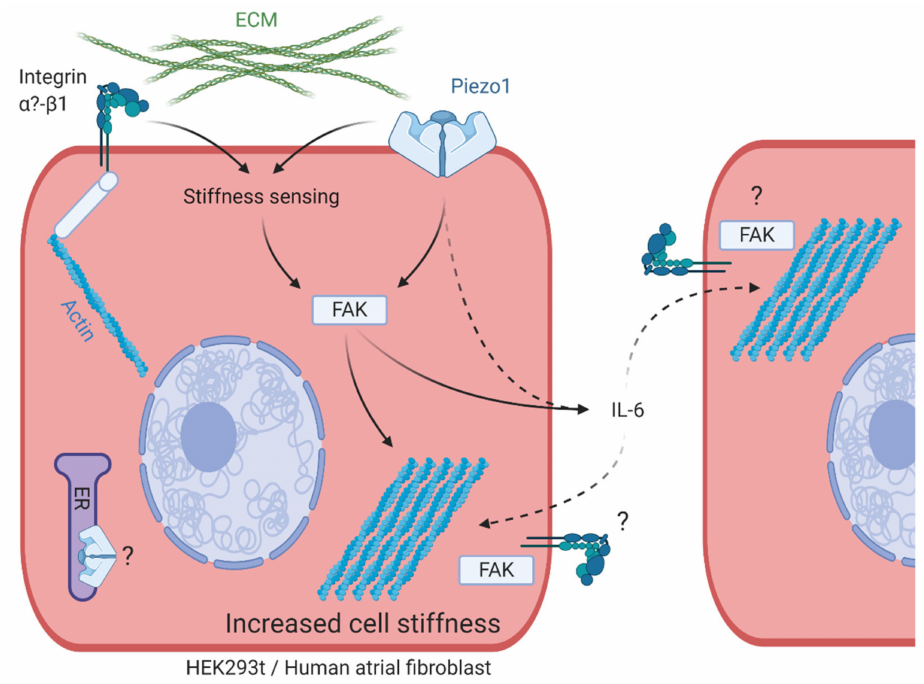
Figure 8. Schematic summarizing the proposed pathway for Piezo1-induced cell stiffening (PiCS). Piezo1 and integrin- β 1 can independently activate FAK, leading to a reorganization of the actin cytoskeleton, and ultimately changing the cell’s mechanical properties. Increased Piezo1 expression induces enhanced IL-6 secretion which is required for autocrine and paracrine induction of cell stiffening. ECM = extracellular matrix. FAK = focal adhesion